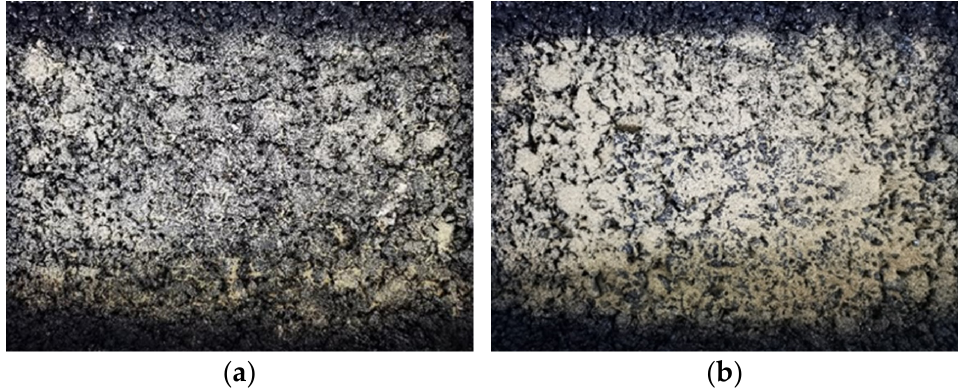
Figure 4. The accumulation patterns of different aeolian sands are 30 g ( a ) and 70 g ( b ), respec- tively.